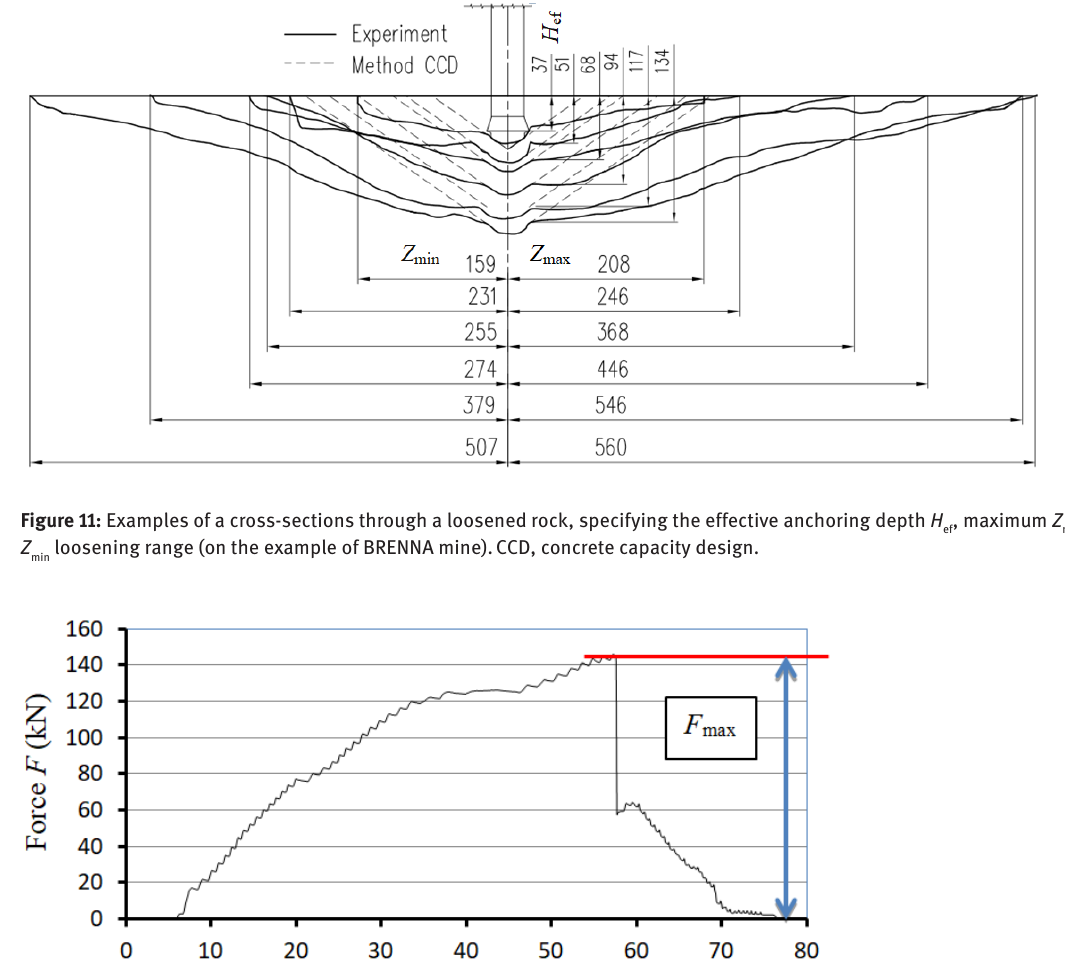
Figure 12: Determination of maximum force F